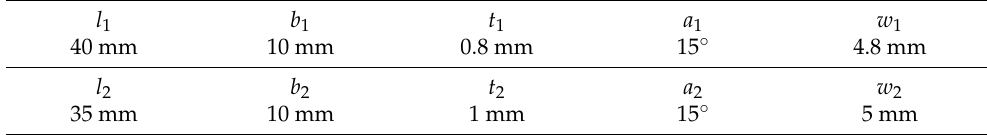
Figure 3. Design parameters of the mechanism. Table 1. Main parameters of the mechanism.